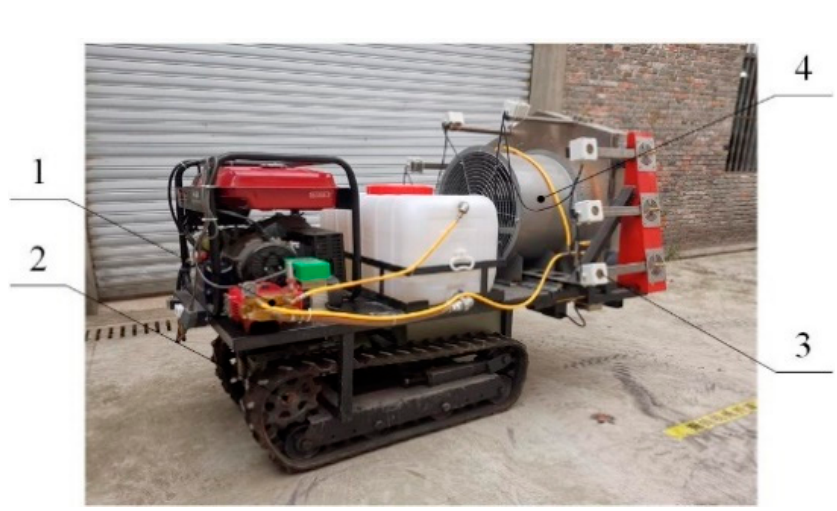
Figure 1. The prototype of a jet-type orchard remote control sprayer: (1) spraying operation depart- ment; (2) carrying and power unit; (3) automatic targeting and position adjustment system; (4) air supply operation department.